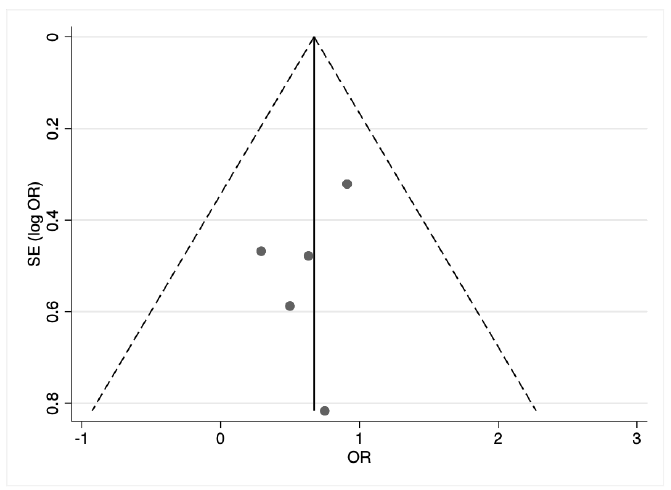
Figure 7. Publication bias.